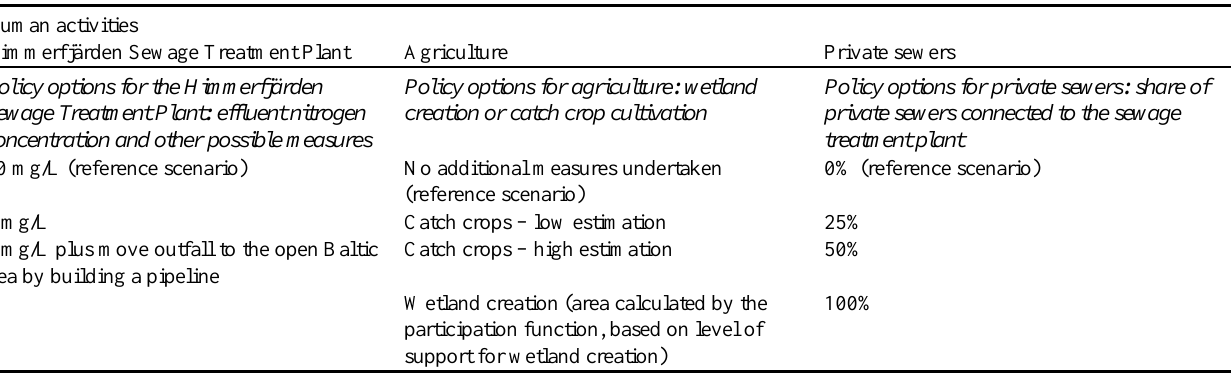
Table 1 . Policy options for the simulation model (including policy options for the reference